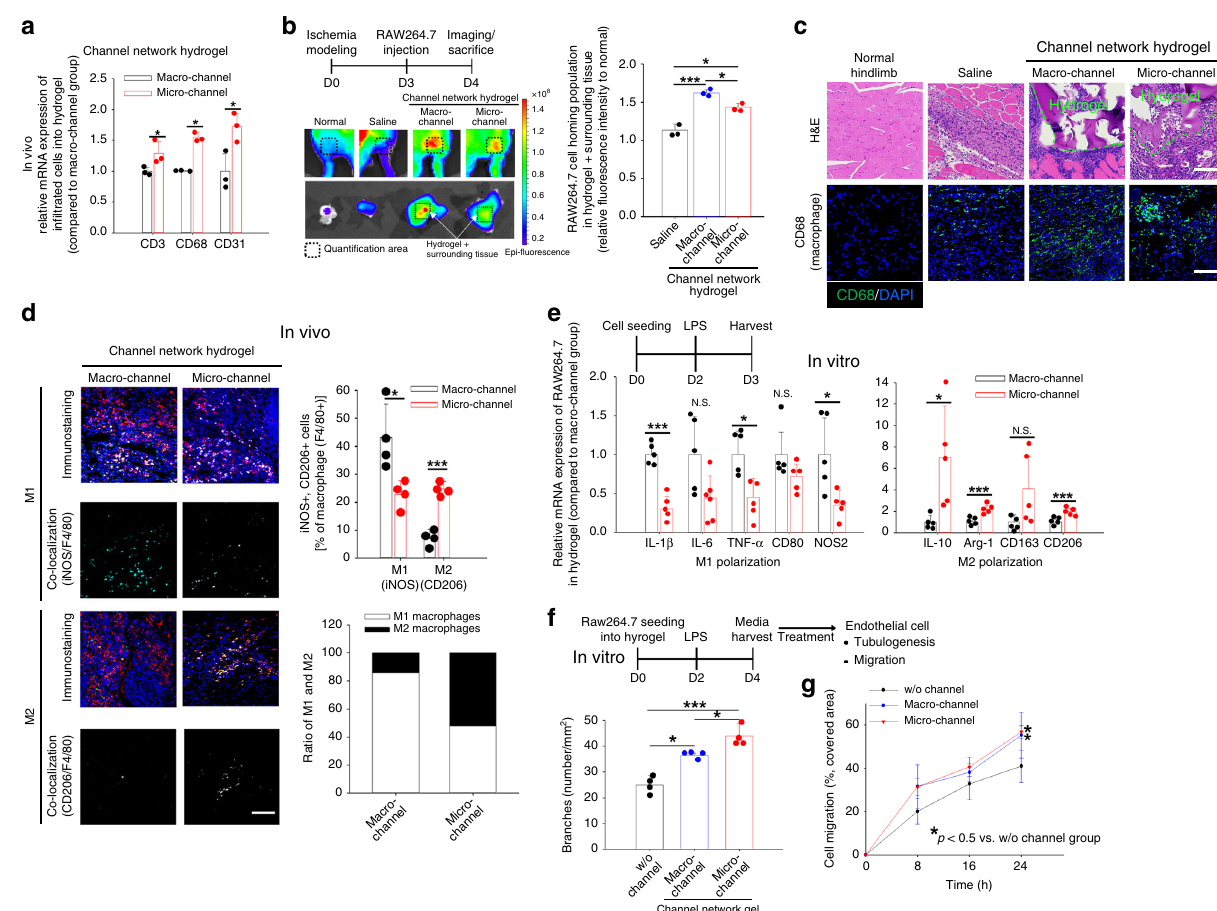
Fig. 3 Monocyte/macrophage responses to test groups in a mouse model of hindlimb ischemia. a Gene expression (CD3, CD68, and CD31) of in fi ltrated cells into macro- versus microchannel network hydrogels only after removing surrounding tissues at day 14 post-implantation by qRT-PCR ( N = 3). Data presented are mean ± SEM. Statistical signi fi cances are determined using a two-tailed Student ’ s t -test; * p < 0.05 between lined groups. b IVIS images of monocyte in fi ltration into the implant site (hydrogel + surrounding tissue) of each test group on day 1 post intravenous administration of Vivotrack680-labeled RAW264.7 cells, followed by quanti fi cation of the ratio in ischemic to normal hindlimb ( N = 3). Data presented are mean ± SEM. Statistical signi fi cances are determined using one-way ANOVA with Tukey post-hoc pairwise comparisons; * p < 0.05 and *** p < 0.005 between lined groups. c Representative H&E and immunostaining (CD68) images of ischemic hindlimb tissues at the implant site. Scale bar = 100 µ m. d Confocal images of macrophage polarization markers (M1: iNOS versus M2: CD206, both in green), a mouse macrophage marker (F4/80 in red), and nucleus (DAPI in blue) at day 14 post-implantation. The corresponding M1 or M2 cell number % out of the total macrophage number (F4/80 + ) as well as M1/M2 ratios in the macro- and microchannel groups were determined quantitatively. Scale bar = 100 µ m. Data presented are mean ± SEM. Statistical signi fi cances are determined using a two-tailed Student ’ s t -test; * p < 0.05 and *** p < 0.005 between lined groups ( N = 4). e Gene expressions of M1 (IL-1 β , IL-6, TNF- α , CD80, and NOS2) and M2 (IL-10, arginase-1, CD-163, and CD-206)] markers in mouse macrophages (RAW264.7) post-culture within macro- versus microchannel network hydrogels in vitro by qRT-PCR ( N = 5). Data presented are mean ± SEM. Statistical signi fi cances are determined using a two-tailed Student ’ s t -test; * p < 0.05 and *** p < 0.005 between lined groups (N.S.: not signi fi cant). Data presented are mean ± SEM. Quanti fi cation of endothelial cell (human umbilical vein endothelial cell, HUVEC) f tubulogenesis and g migration induced conditioned media of RAW264.7 cells in vitro ( N = 4). Dots represent each replicate of HUVEC-seeded wells in a 24-well plate. Data presented are mean ± SEM. Statistical signi fi cances are determined using one-way ANOVA with Tukey post-hoc pairwise comparisons; * p < 0.05 and *** p < 0.005 between lined groups. Source data are provided as a Source Data fi con fi rmed by marker expression of ECs (CD31) and EPCs (CD34 and CD133) by immunostaining (Fig. 4e – f). In addition, when GFP-HUVECs were cultured within the channel network hydrogels under media perfusion, in vitro microchannel endothelialization was more ef fi cient than in the macrochannels, as presented by EC lining, tight junction, and capillary-like sprouting (Fig. 4g and Supplementary Fig. 8 and Movie 1). Together, the overall interpretation of the results (Figs. 3 and 4) suggests a causative role of M2 macrophage polarization in promoting EC in fi ltration and ingrowth as a mechanism guiding host vessel ingrowth and perfusion connection with microchannel networks.